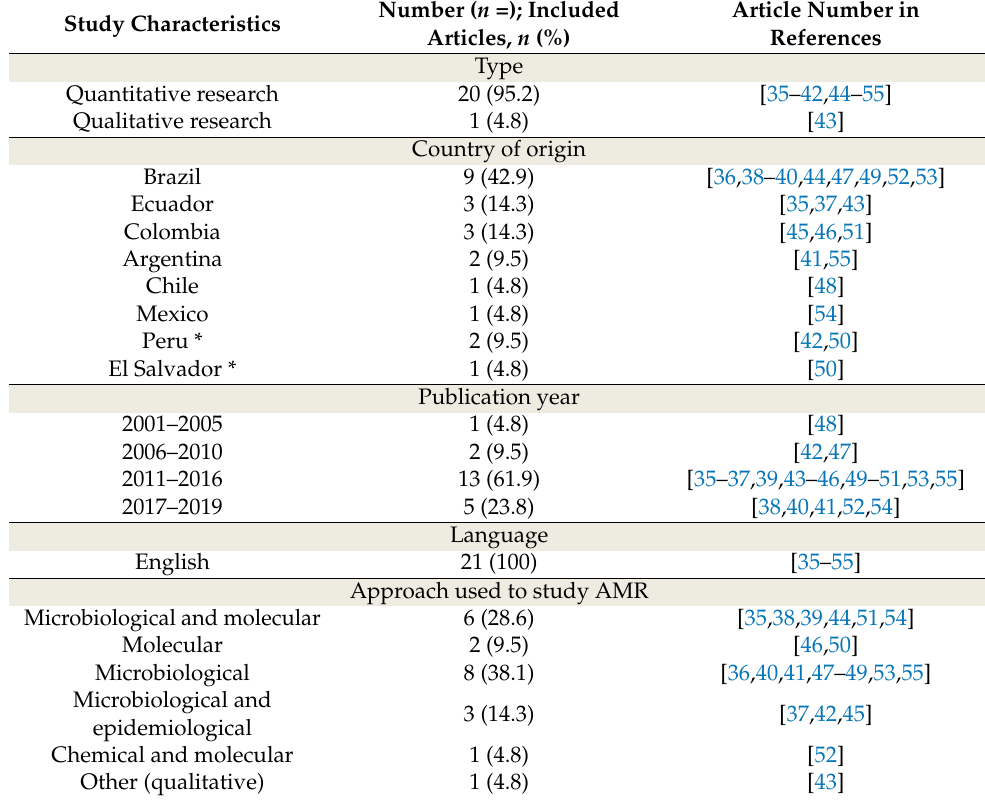
Table 2. Basic details of included publications.